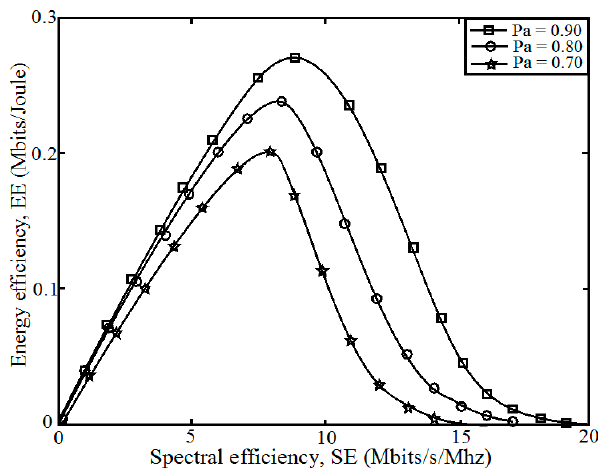
Figure 8. The relationship between SE and EE when the spectrum detection power is taken into account in the CCRNs with different access probabilities Pa.